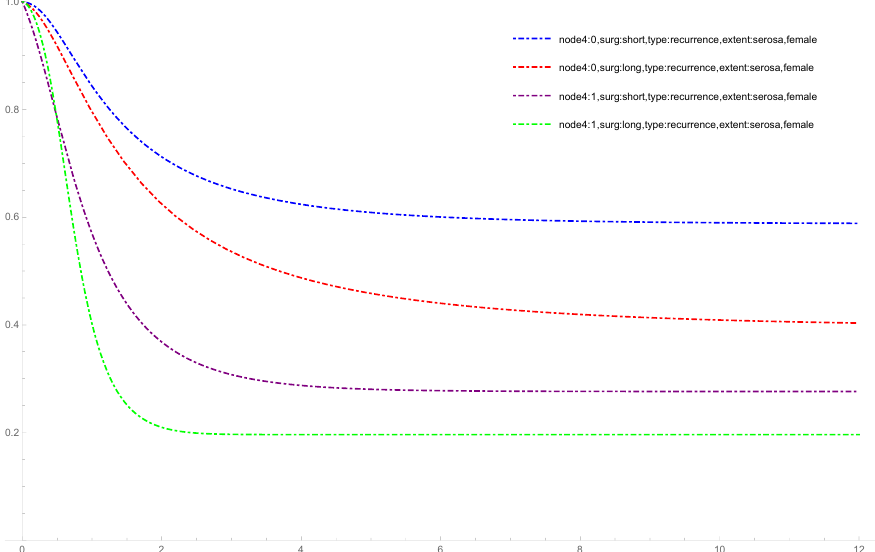
Figure 4. Plots of the survival functions for the colon data based on F-SCR/GeTNH model stratified by surg status for patients with more than 4 positive lymph nodes (0 = no, 1 = yes); event type: recurrence; sex: female; extent of local spread: